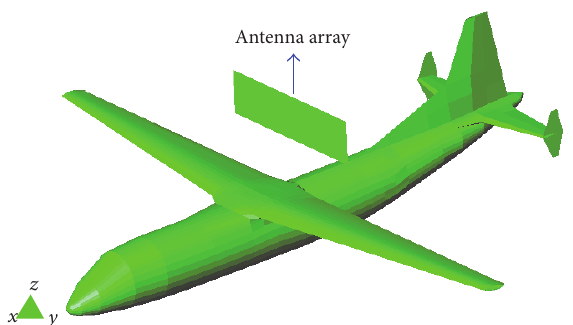
Figure 18: Model of airborne array.